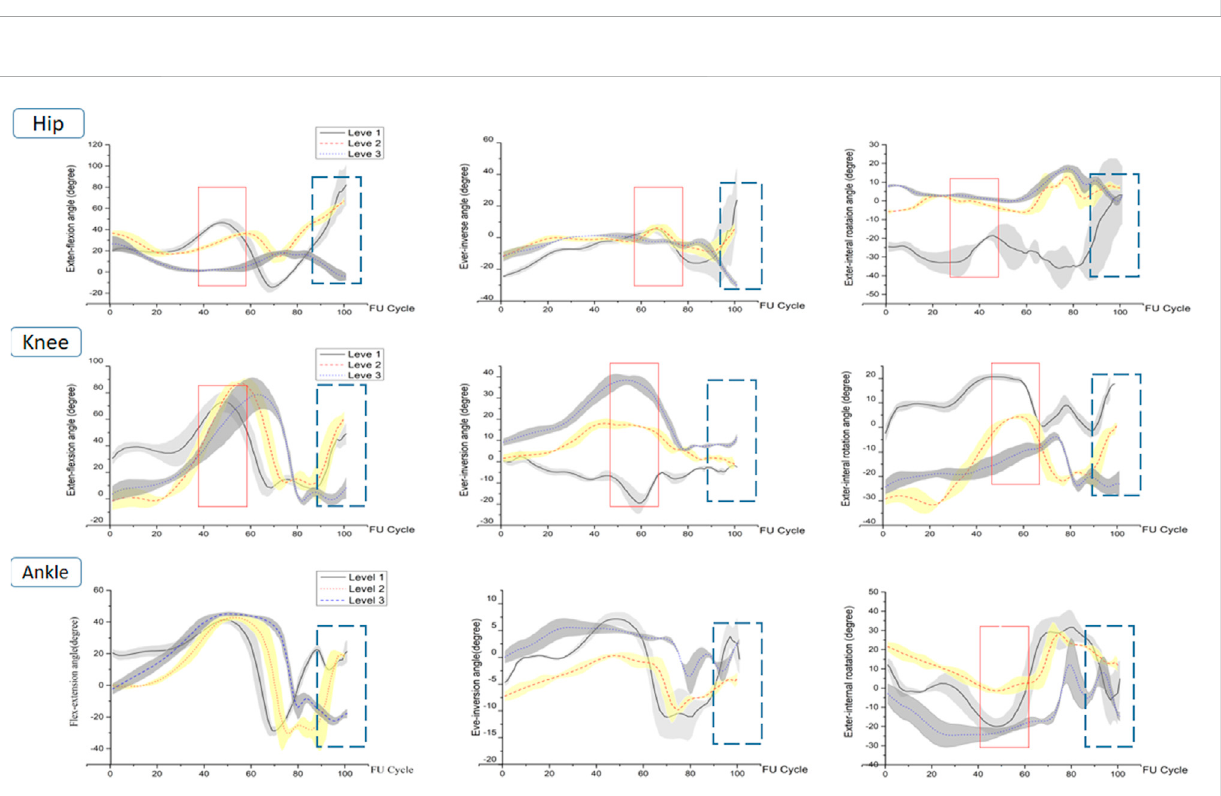
Left lower-limb joint ROM of level 1, level 2, and level 3 during FUS. (1) The red rectangles represent the areas of difference in joint ROM during the take-off preparation phase. (2) The blue dashed rectangles represent the areas of difference in joint ROM during the landing buffer